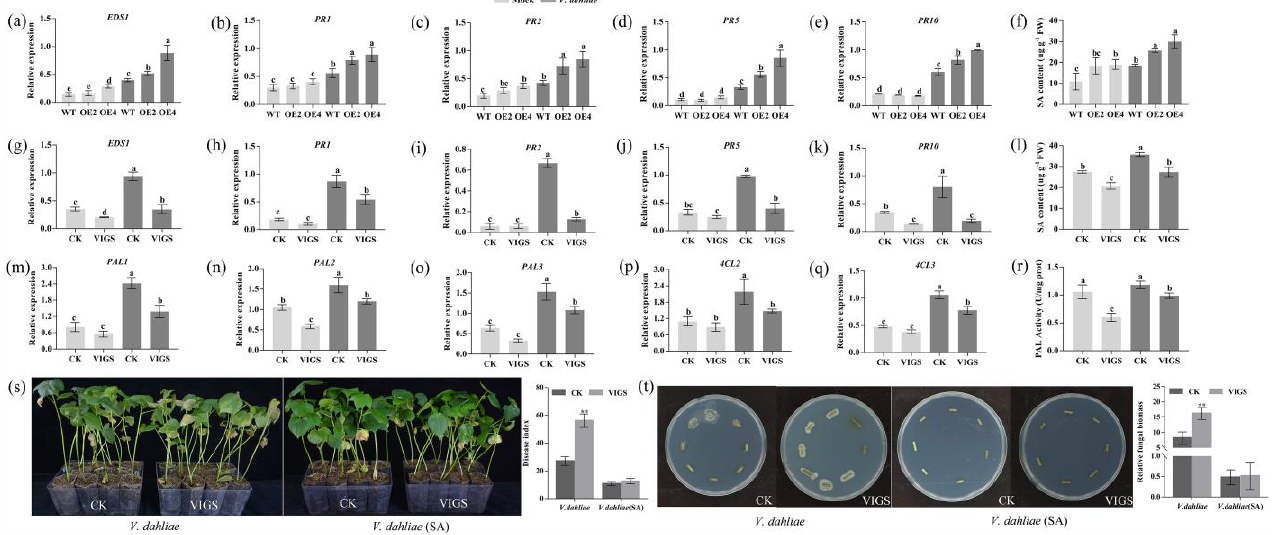
Figure 8. Detection of SA pathway genes. ( a – e ) qRT-PCR analysis of the expression of SA pathway genes in wild-type, transgenic Arabidopsis line. ( g – k ) qRT-PCR analysis of the expression of